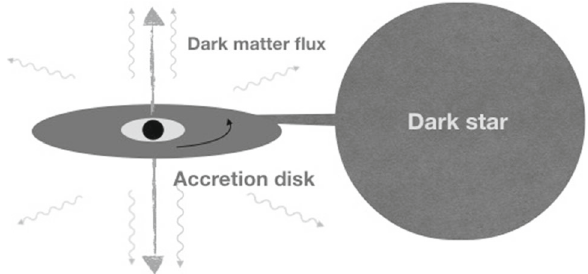
Fig. 4 The schematic diagram of black hole and dark star(or axion clump) binary system. If dark matter particles have enough self- interactions, they can clump together to form a dark star. If such dark star happens to be accreted to one black hole, it is possible to form the dark matter disc and dark matter